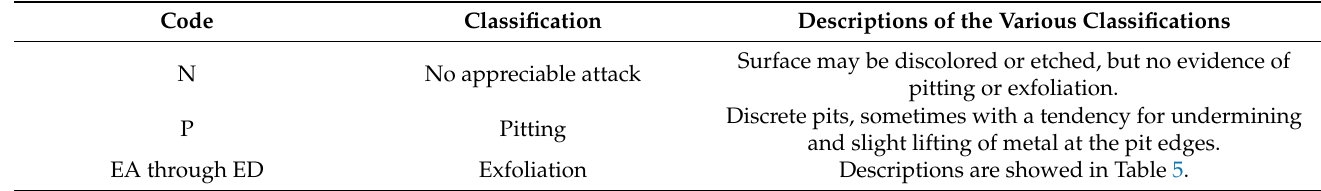
Table 4. The spalling corrosion rating details.